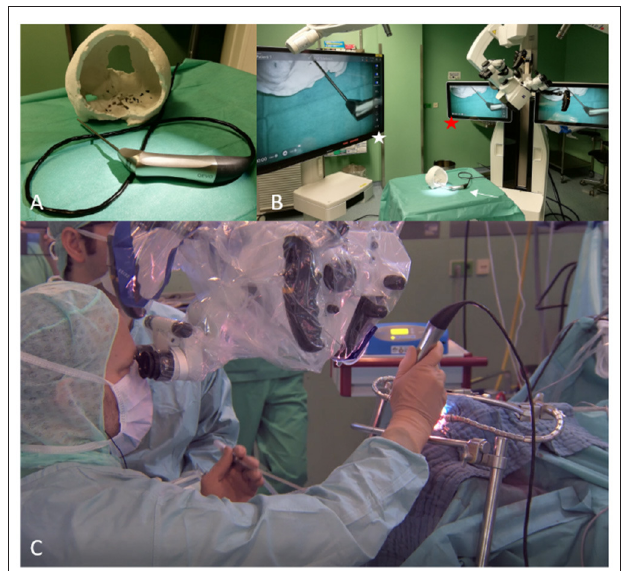
FIGURE 1 | QEVO ® , KINEVO ® , and monitors in the Operating Room. (A) QEVO ® micro-inspection tool. (B) QEVO ® (white arrow) connected to KINEVO ® surgical microscope (red asterisk) and to the external monitor (white asterisk). (C) Simultaneous use of QEVO ® and KINEVO.